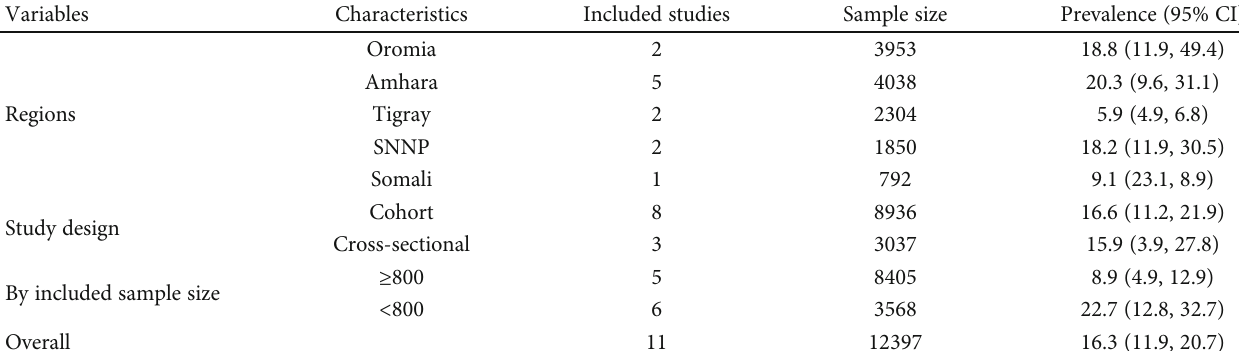
Table 2: The prevalence of neonatal mortality by region, study design, and sample size.